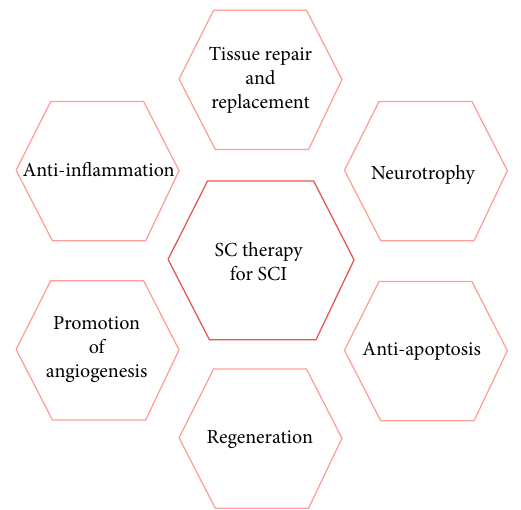
Figure 2: The mechanisms of stem cell (SC) therapy for spinal cord injury (SCI). The potential mechanisms of stem cell therapy for SCI include tissue repair and replacement, neurotrophy, regeneration, promotion of angiogenesis, antiapoptosis, and anti-in fl